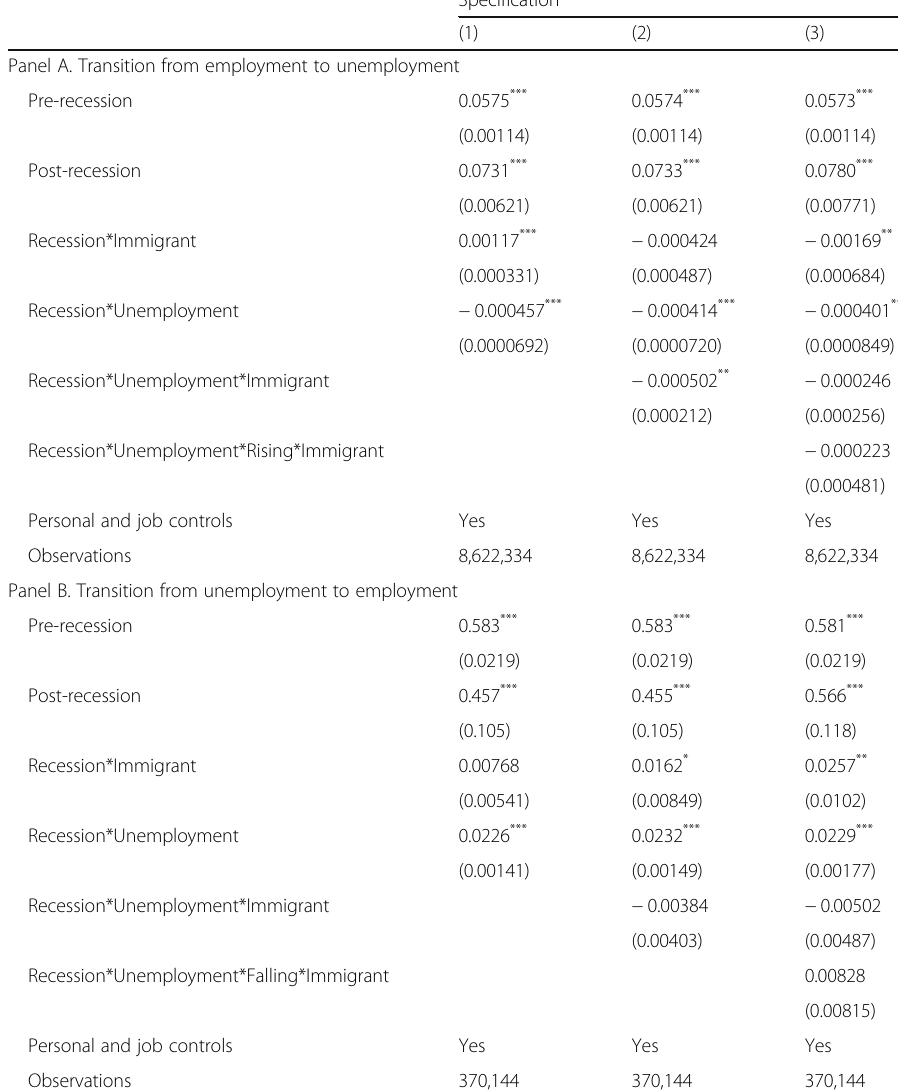
Table 9 Test for structural changes brought about by the Great Recession: matched CPS data, 1996 –